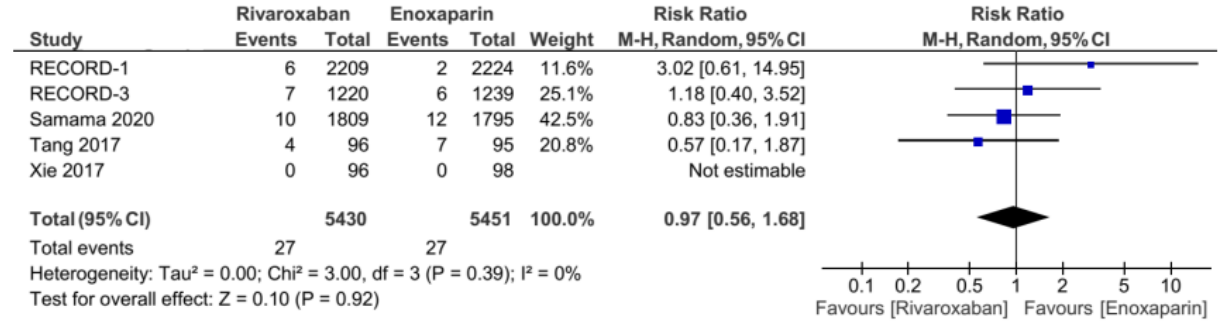
Figure 8. Incidence of major bleeding [5,7,12 –